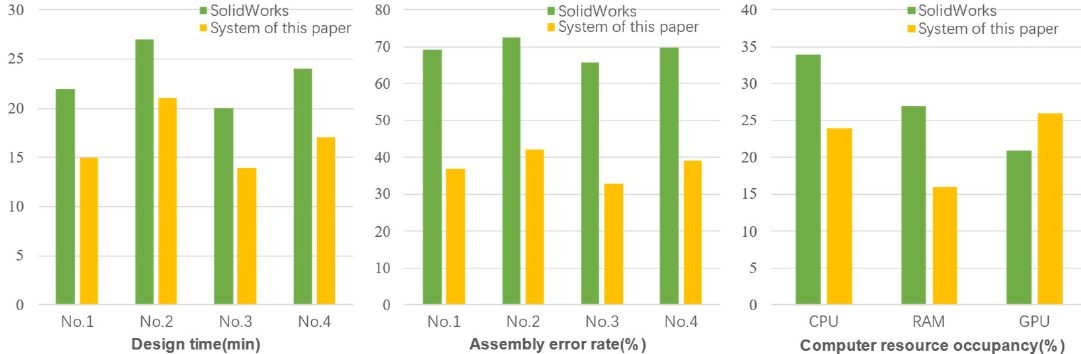
Figure 23. System performance comparison data.